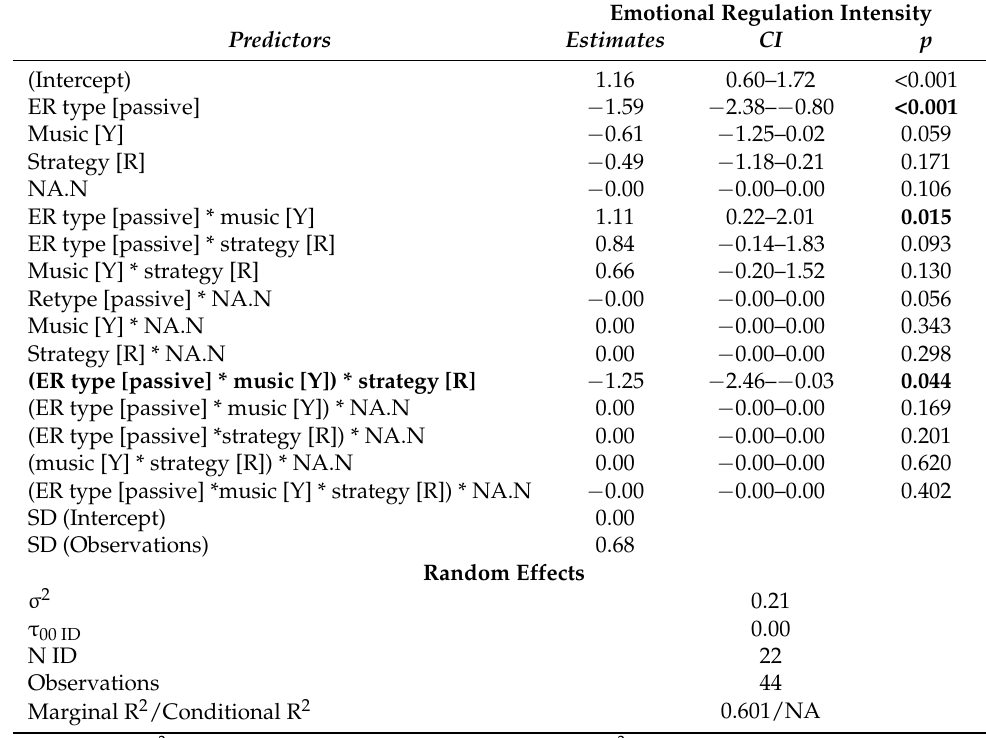
Table A5. Lower DS (lower working memory).